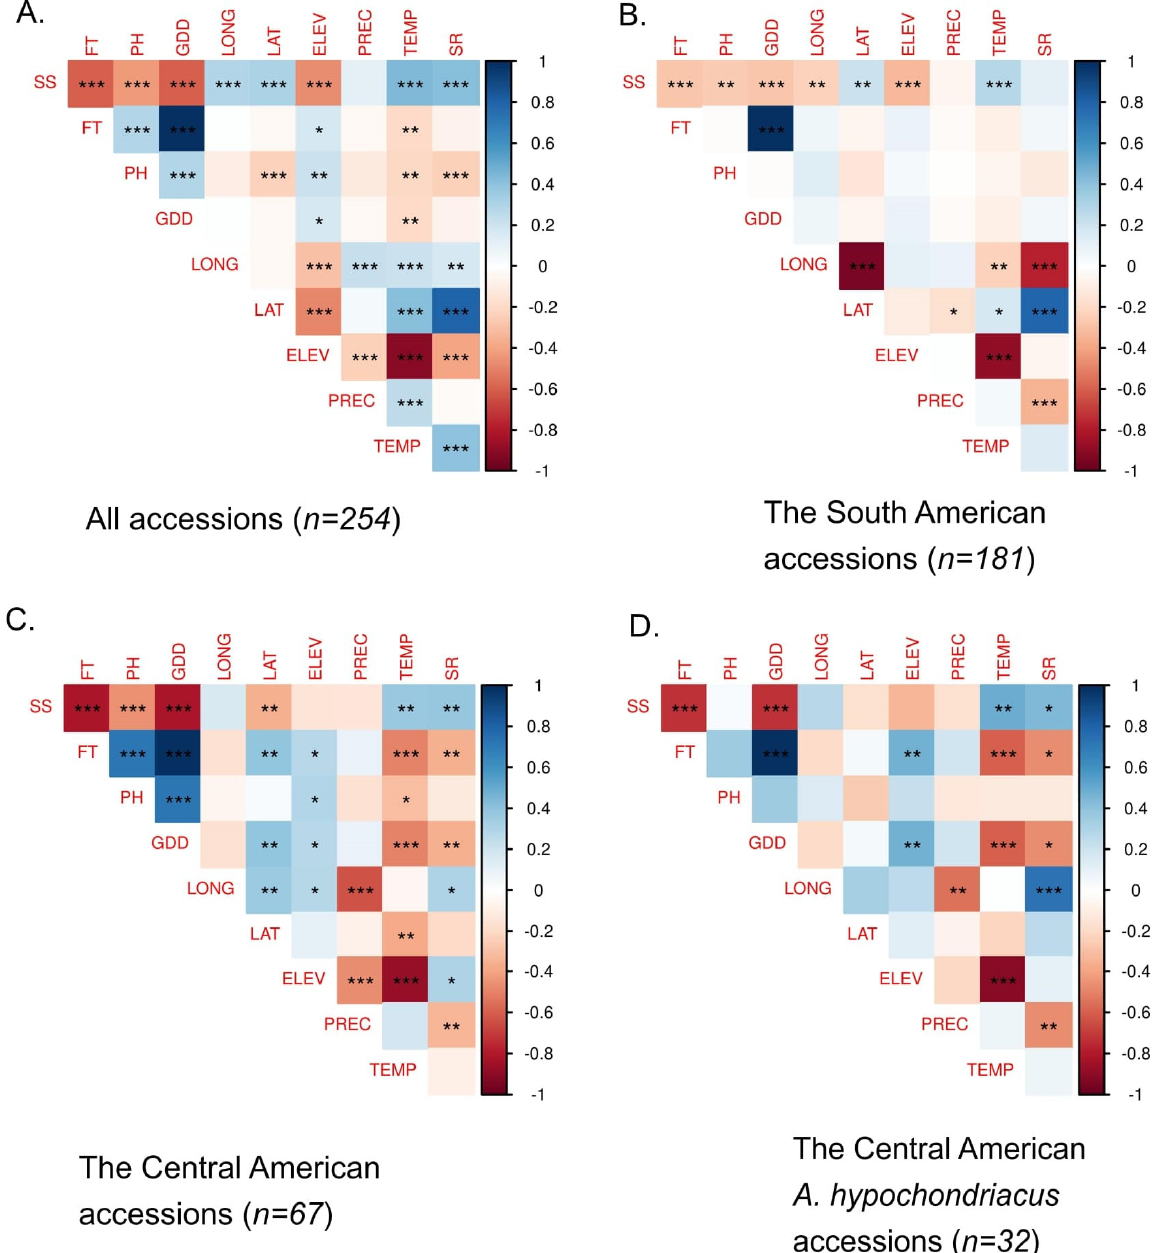
Figure 3. Spearman’s correlation matrix of ( A ) all accessions, ( B ) the South American accessions, ( C ) the Central American accessions and ( D ) the Central American A. hypochondriacus accessions. Phenotypic traits and environmental variables are: SS, seed setting; FT, flowering time; PH, plant height; GDD, growing degree days; LONG, longitude; LAT, latitude; ELEV, elevation; PREC, precipitation and TEMP, temperature. In the correlation matrices *, **, *** indicate significance at p < 0.05, p < 0.01 and p < 0.001, respectively.